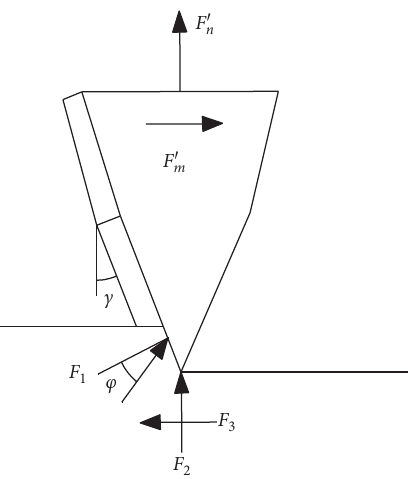
Figure 3: Single drill tooth force diagram.